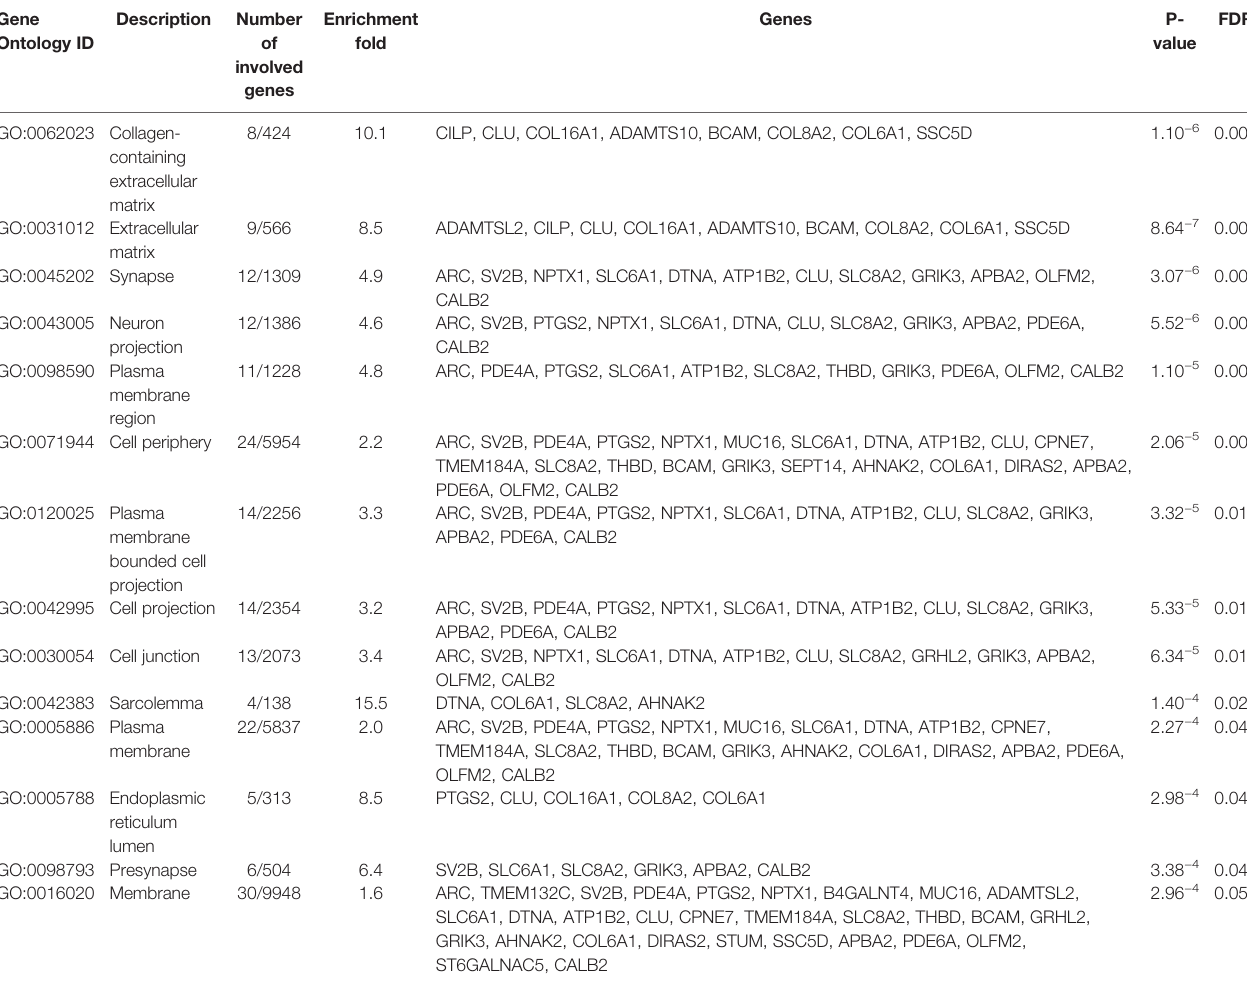
TABLE 3 | GO enrichment “ cellular component ” data set top results enriched by SSA/DA therapy in PitNET patients, ranked by statistical signi fi cance. Gene Ontology ID